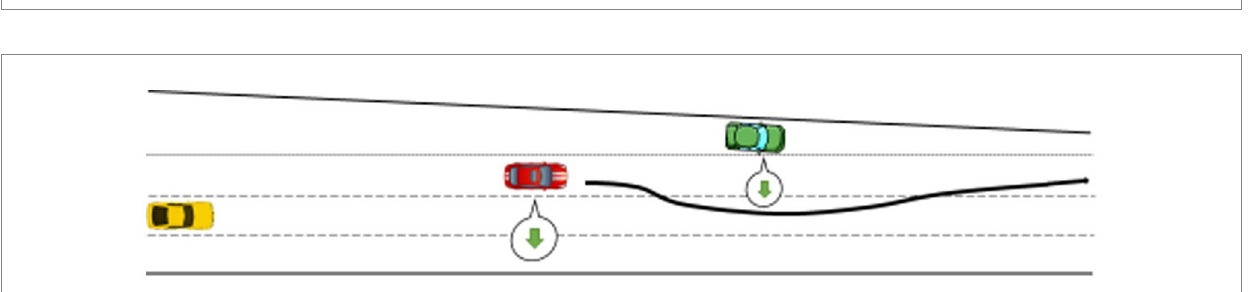
FIGURE 4 Control condition: the ego vehicle, in red, gives way to the green vehicle merging-in and then overtakes